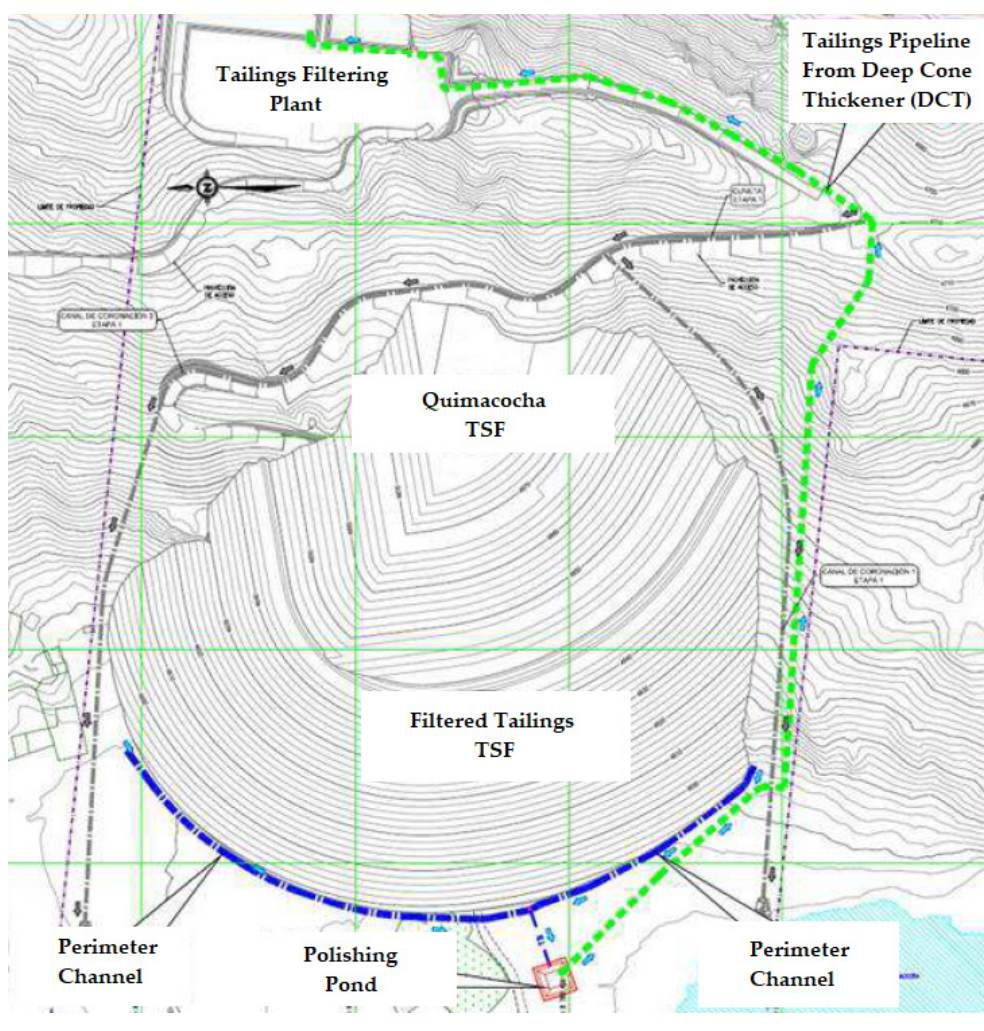
Figure 77. Chungar Filtered TSF Layout View.